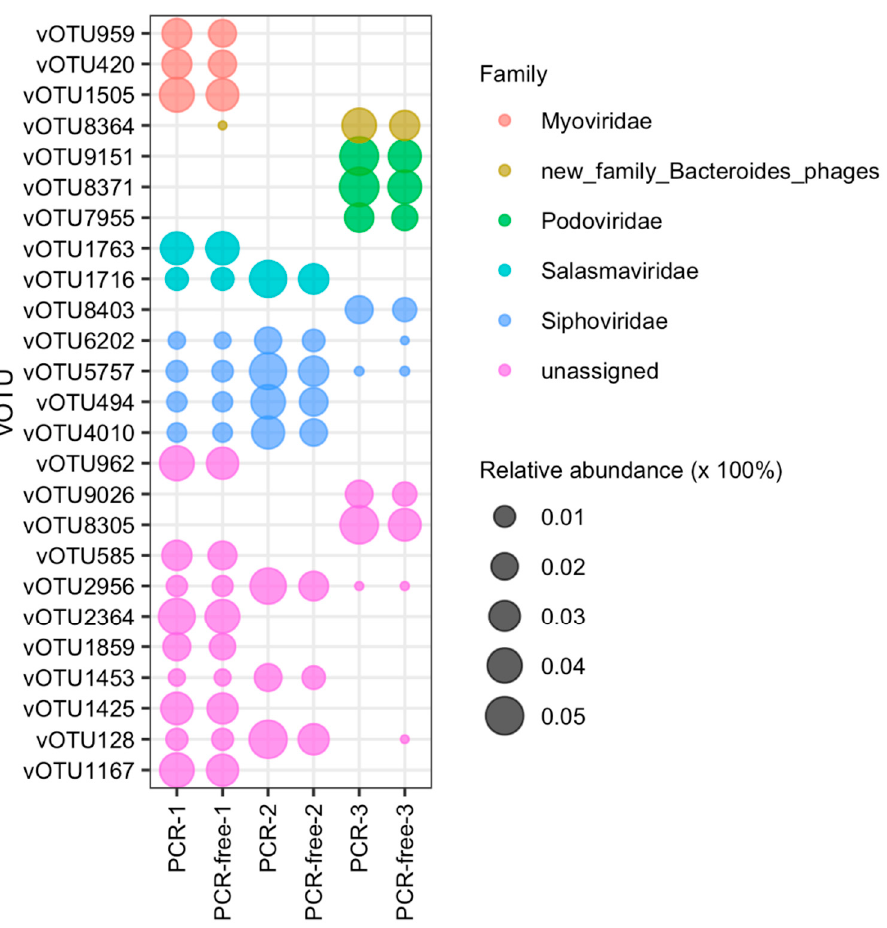
Figure 4. Relative abundance of the top 25 vOTUs from the PCR and PCR-free datasets. Bubble plot showing the relative abundance of the top 25 vOTUs across the datasets with assigned and unassigned taxonomies. Those vOTUs that could not be classified and assigned to appropriate taxonomies by either DemoVir or vConTACT 2.0 were labelled as “unassigned”. The size of bubble represents the relative abundance expressed as percentage (e.g., 0.02 means 2%) and each assigned or unassigned family group was separated in colour.